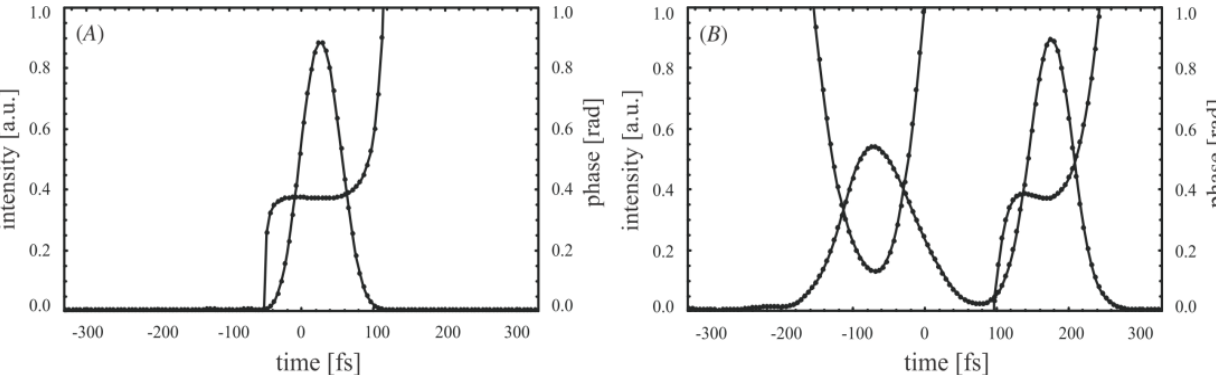
Figure 8. The reconstructed signal 1 ( A ) and signal 2 ( B ) of two unknown pulses corresponding to the VAMPIRE spectrogram shown in Figure 7